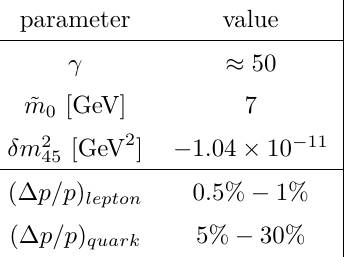
= m 2 − m 2 in the scenario 45 4 5